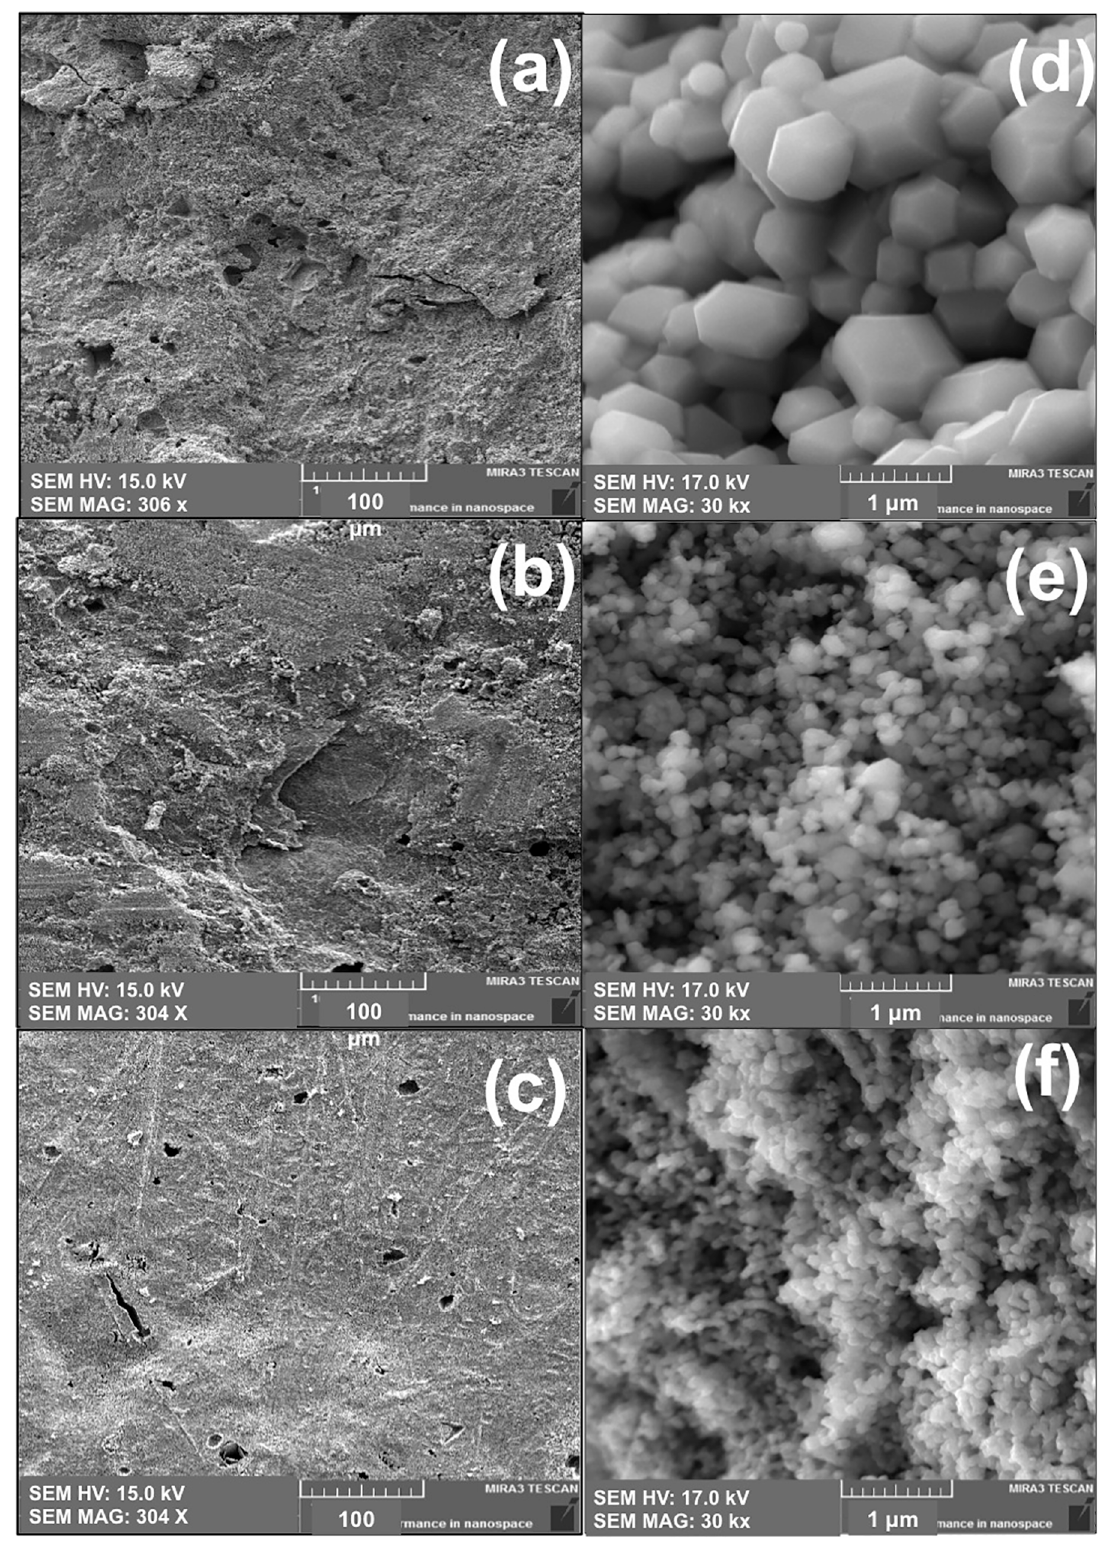
, (b) LBM and (c) LBM with Magnification of 300x, (d) - (f) SEM 3.7 6.2 8.7